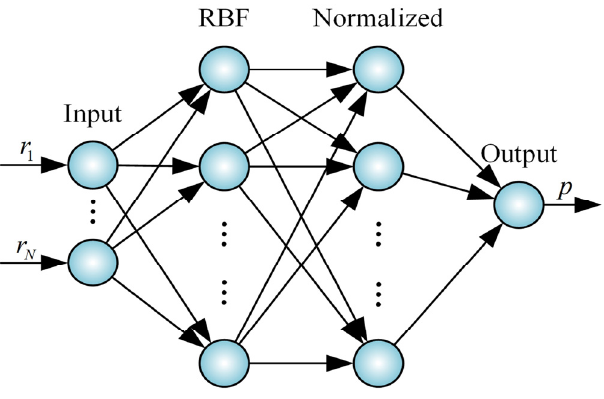
Figure 2. Initial architecture of sensitivity analysis based self-organizing fuzzy neural network with second order gradient algorithm (SOG-SASOFNN).